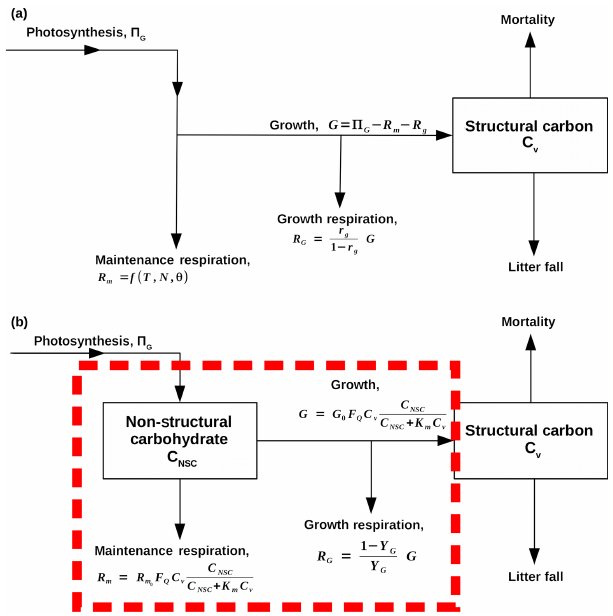
Figure 1. Flow diagrams that demonstrate how SUGAR is designed to change the model structure of carbon allocation within the Joint UK Land Environment Simulator (JULES, Best et al., 2011; Clark et al., 2011). Arrows represent fluxes of carbon, and black boxes represent carbon pools. (a) A representation of the current struc- ture of carbon allocation in JULES. Maintenance respiration ( R m ) depends on temperature ( T ), leaf nitrogen ( N ) and, optionally, wa- ter availability ( θ ). Growth respiration ( R G ) is equal to a constant fraction of growth ( G ), which is equal to photosynthesis ( (cid:53) G ) less total plant respiration ( R G + R m ). Total utilisation of carbon ( R m + R G + G ) is always exactly equal to carbon assimilation by photosynthesis ( (cid:53) G ). (b) A representation of how SUGAR would sit within JULES. The dashed red box represents the model bound- ary of SUGAR. Both maintenance respiration and growth depend on temperature via a Q 10 function ( F Q ), structural biomass ( C v ) and non-structural carbohydrate content ( C NSC ). Growth respira- tion is a constant fraction of